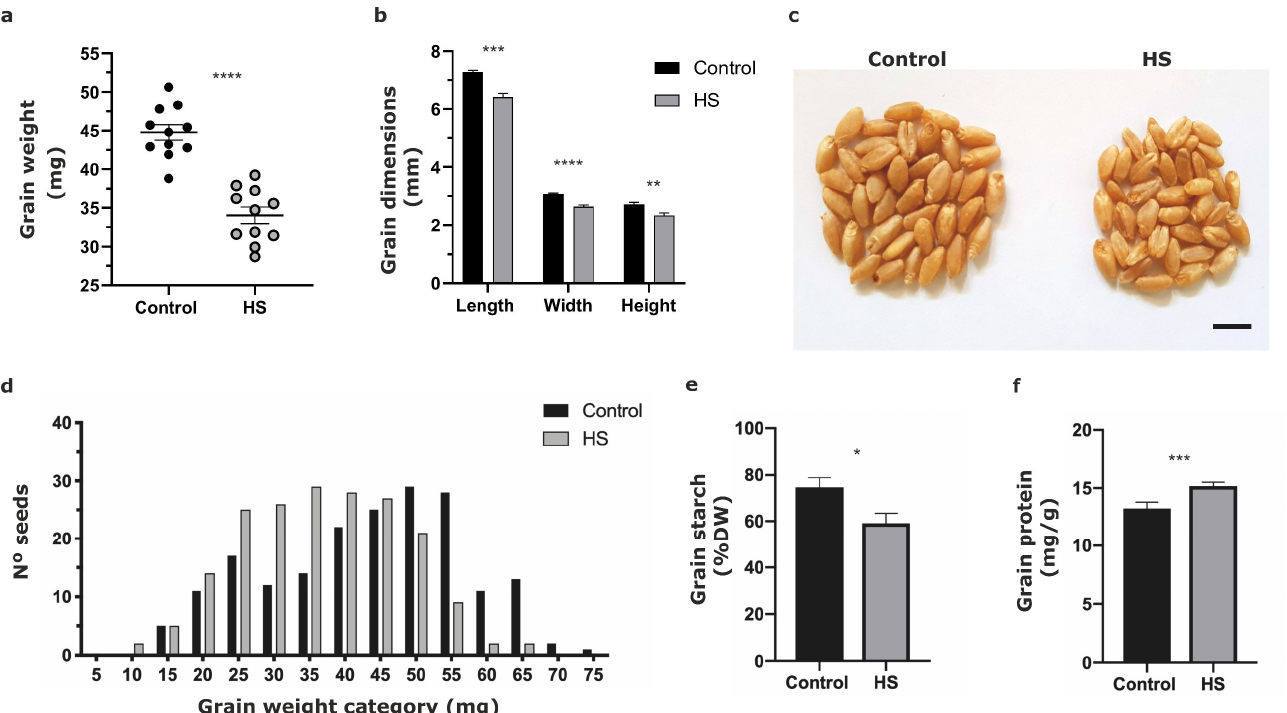
Figure 2. Physiological characterization of durum wheat grains at harvest under HS and control treatments. ( a ) Grain weight. ( b ) Grain dimensions. ( c ) Grain phenotype (40 seeds for each group, Bar: 0.5 cm). ( d ) Grain weight distribution. ( e ) Grain starch and ( f ) grain protein levels. Control (black columns) and heat treatment (gray columns). Each column represents the mean of three rep- licates with ±standard deviations. Significant effects at Student’s t -test, p < 0.05 (*), p < 0.01 (**), p < 0.001 (***), p < 0.0001 (****).